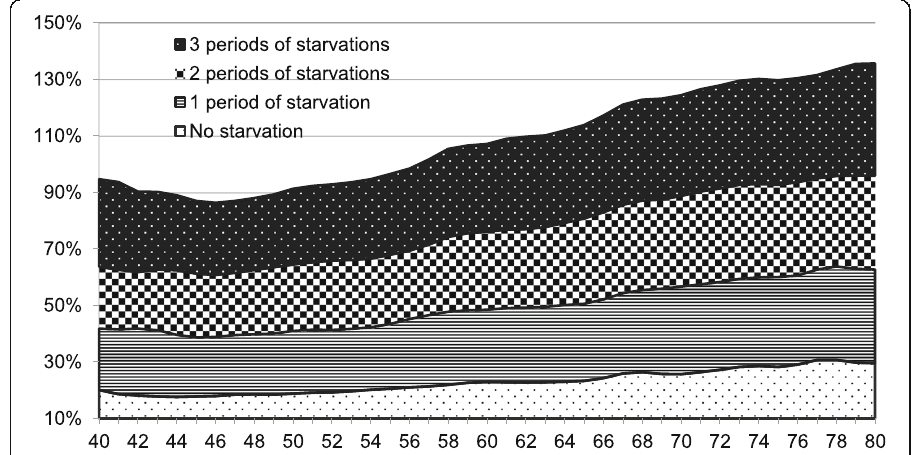
Fig. 3 An area map of the duration of early life adversity and the probability of poor health (predicted value). Note: The vertical intercept of each stripe in the graph is the probability of poor health caused by adversity, starting at the top of the following groups, unit/percent. The abscissa is the age,